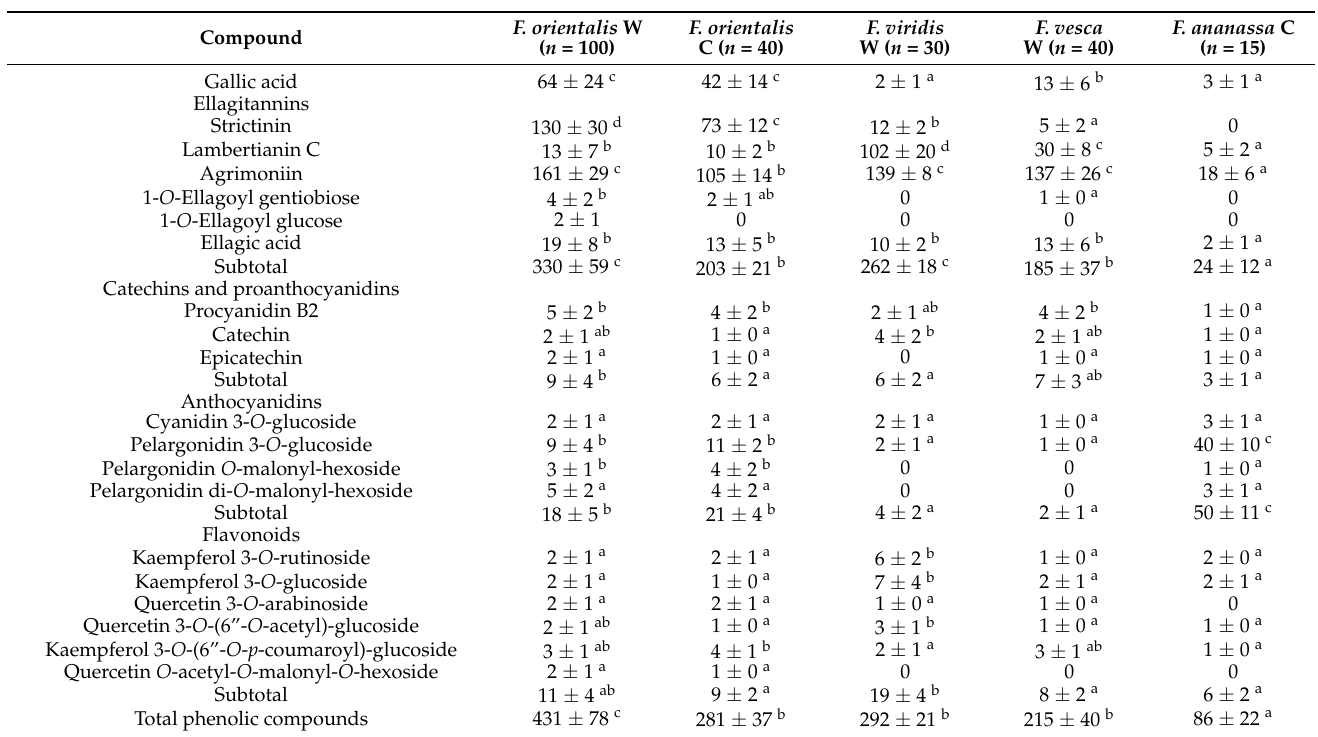
Table 2. Quantitative content of 20 phenolic compounds in the fruits of wild (W) and cultivated (C) Fragaria species, mg/100 g FW ( ±